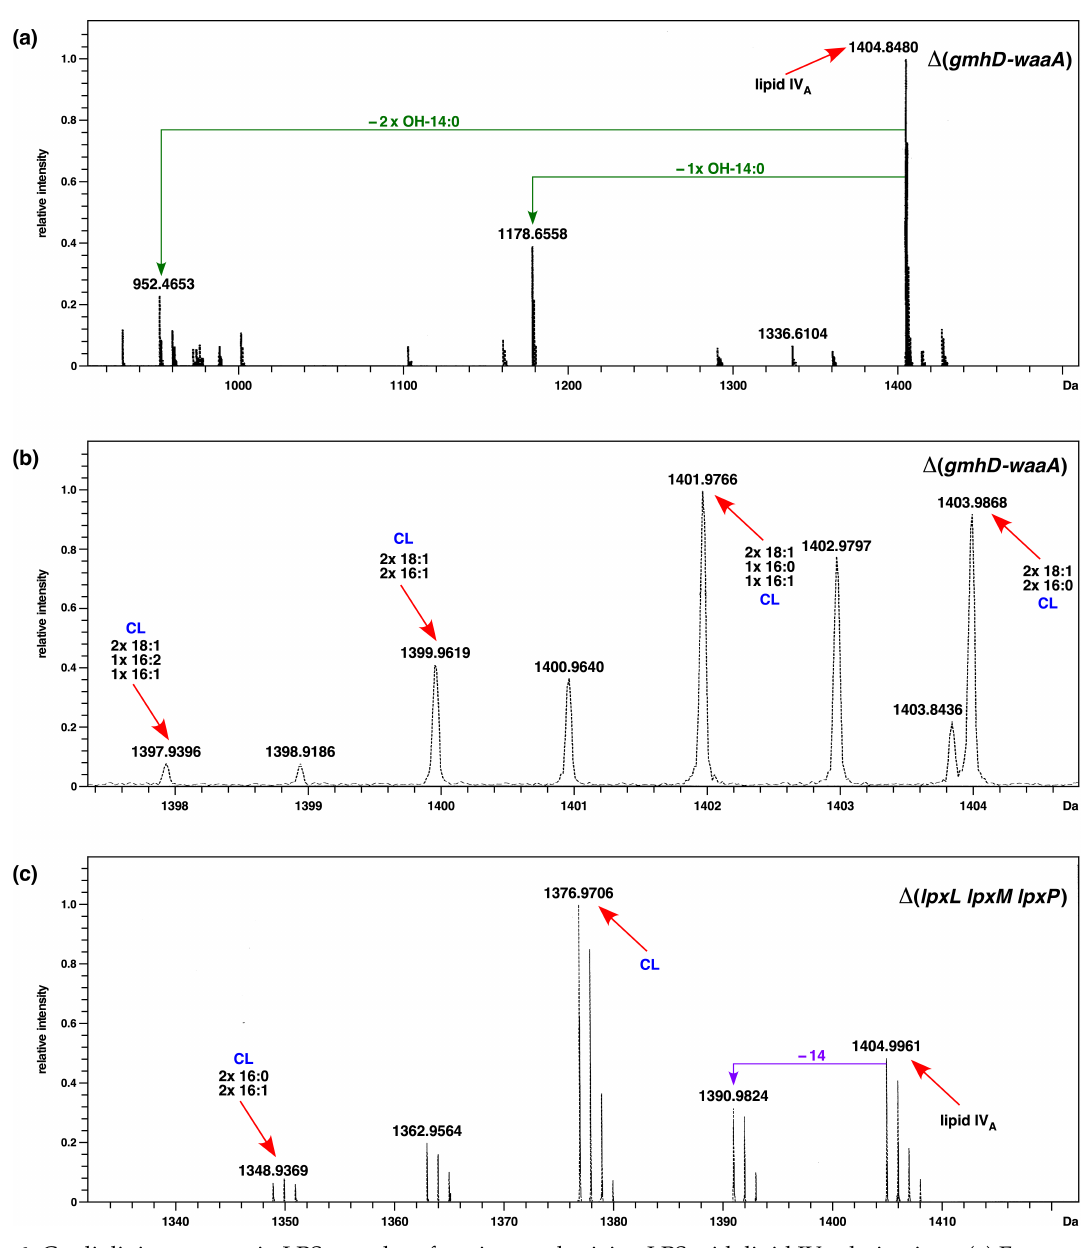
Figure 6. Cardiolipin presence in LPS samples of strains synthesizing LPS with lipid IV A derivatives: ( a ) Fragmentation mass spectra with ion peak at 1404.8 Da corresponding to lipid IV A from the ∆ ( gmhD–waaA ) strain grown at 21 ◦ C. ( b ) Fragmentation mass spectra with ion peak at 1403.98 Da, obtained from the ∆ ( gmhD–waaA ) strain grown at 21 ◦ C. ( c ) Mass spectra of the lipid A part of LPS obtained from the ∆ ( lpxLMP ) strain grown at 30 ◦ C in M9 medium. Charge deconvoluted ESI FT–ICR mass spectra in negative ion mode are presented. The mass numbers refer to monoisotopic peaks with the proposed composition. The mass peaks marked CL correspond to the predicted presence of cardiolipin species with varying acyl chain lengths, with the predicted composition